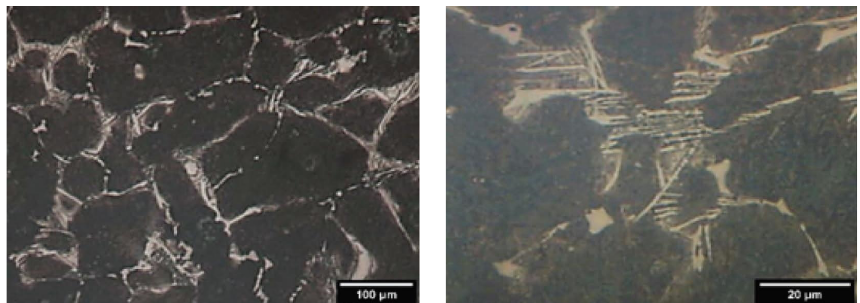
Figure 8: Microstructure of 3V-8W-HC steel in the as-cast condition.